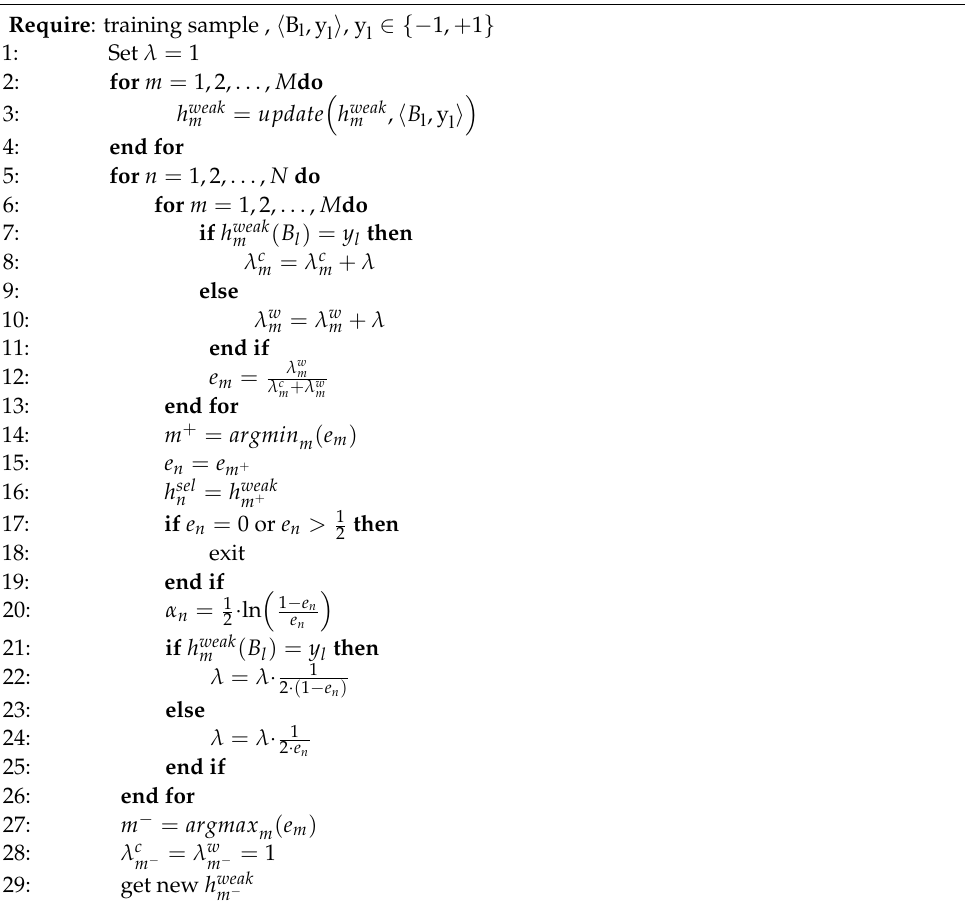
Algorithm 1: Online adapting